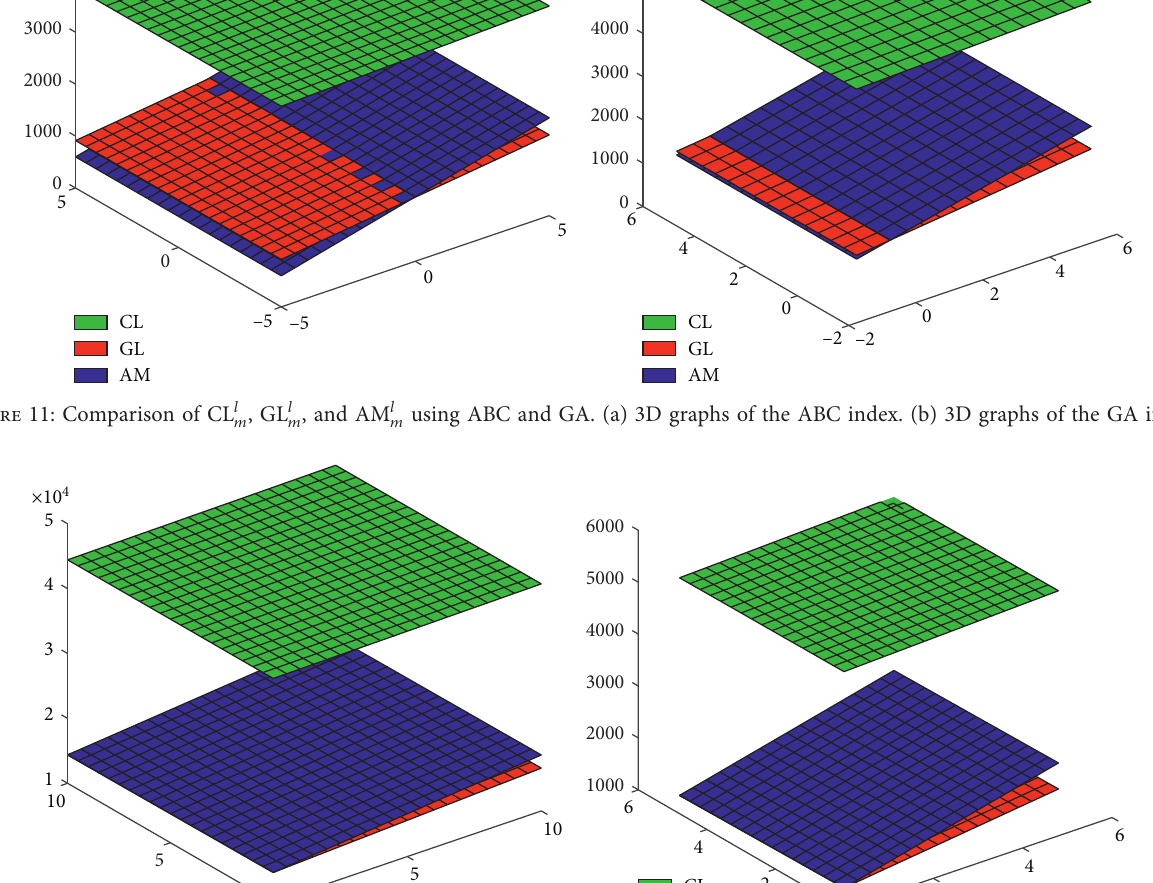
l l m , GL m , and AM m using SDD and ISI. (a) 3D graphs of the SDD index. (b) 3D graphs of the ISI.